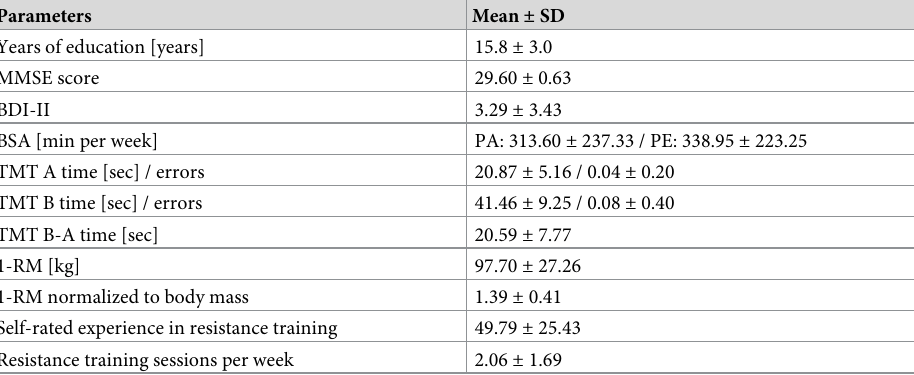
Table 1. Personal data for the characterization of the participants and results of the screening test in the investi- gated sample; BDI: Becks Depression Inventory; BSA: Physical activity questionnaire, derived from German ‘Bewegungs- und Sportaktivita¨tsfragebogen’; MMSE: Minimal Mental State Examination; PA: Physical activity; PE: Physical exercise; 1-RM: One-repetition maximum; TMT: Trail Making